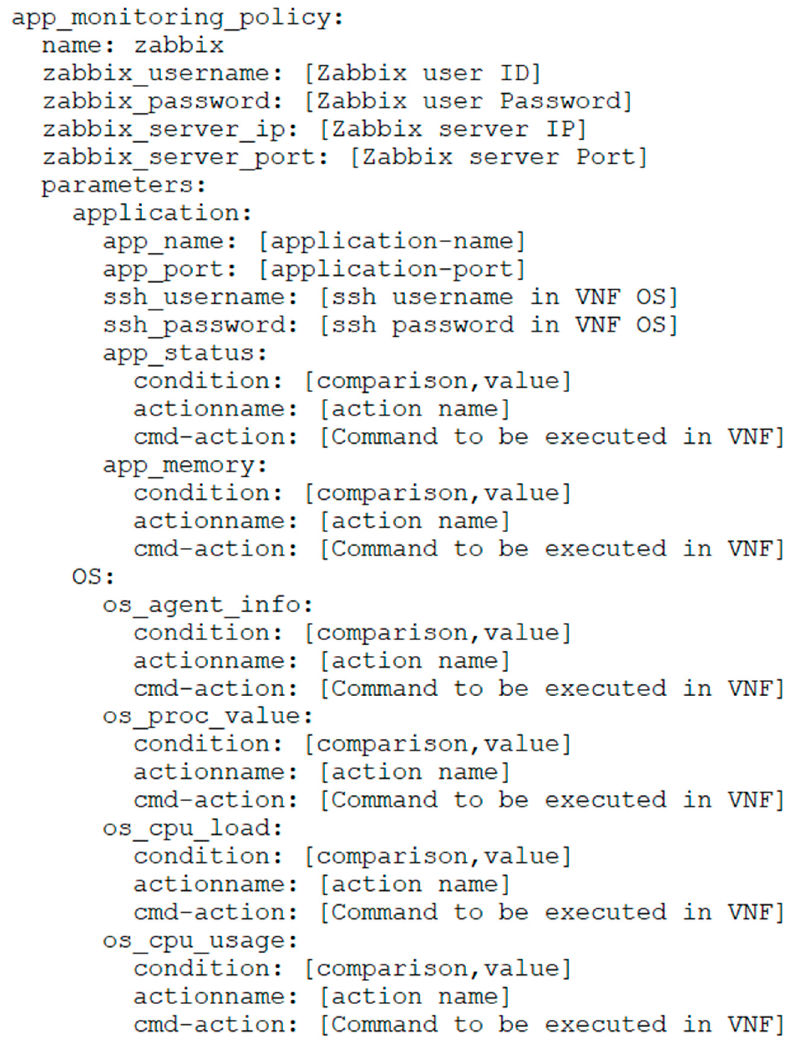
Figure 5. Virtual Network Function descriptor (VNFD) template for monitoring .